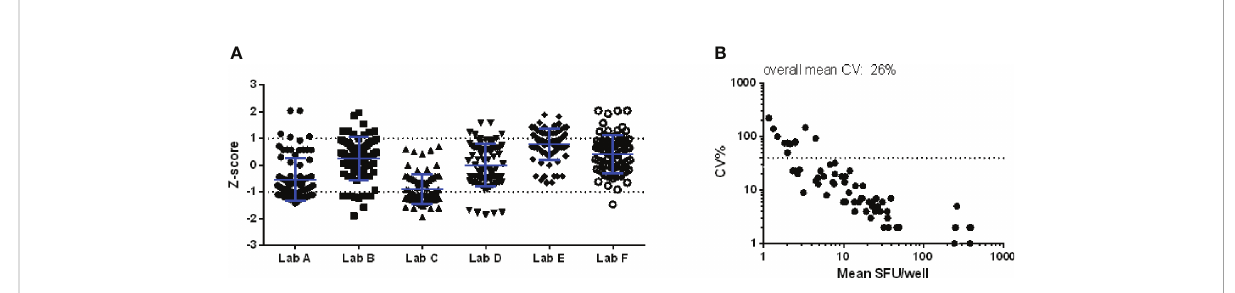
FIGURE 3 Pilot study 2. An IFN- g ELISpot plate with 84 wells to be scored was distributed to 6 laboratories within one month after preparation. Z-scores per well per lab (A) and the CV per well (B) are shown. The dotted line in the right panel indicates the CV of 40%, commonly applied as a threshold of acceptable variation in CMI